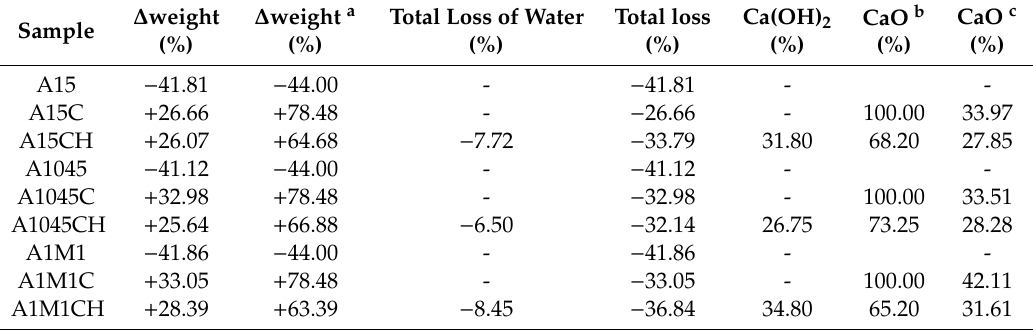
a Theoretical value; b CaO total; c CaO reacted from total of